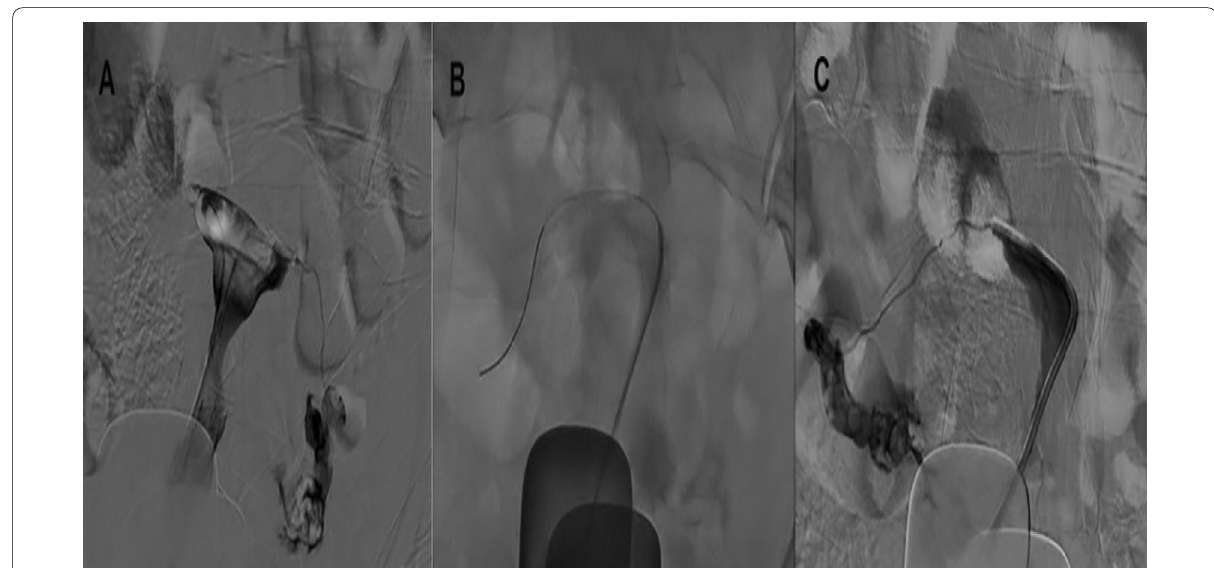
Fig. 1 Hysterosalpingogram before and after FTR for a 28‑year‑old patient. A Hysterosalpingogram showing left tubal patency and proximal right tubal obstruction. B Right tube recanalization using catheter‑wire technique. C Selective right salpingogram following recanalization showing patent tube with free peritoneal spillage. FTR fallopian tube